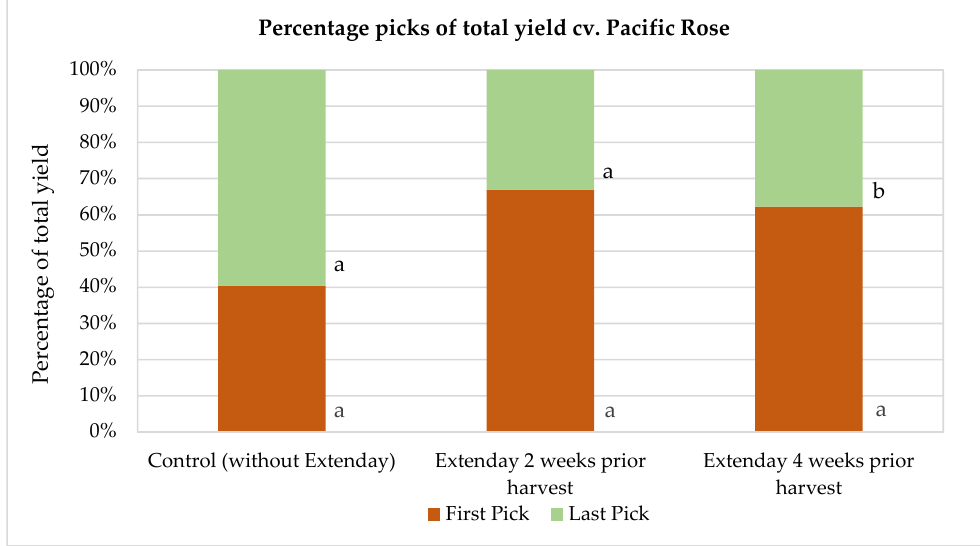
Figure 4. Summation of yield in each pick of cv. Pacific Rose as dependent on the timing of reflective mulch in Motueka, New Zealand, (41° S). (Picks with different letter for the same treatment are statistically different ( p < 0.05) (n = 60 fruit per treatment per position)).